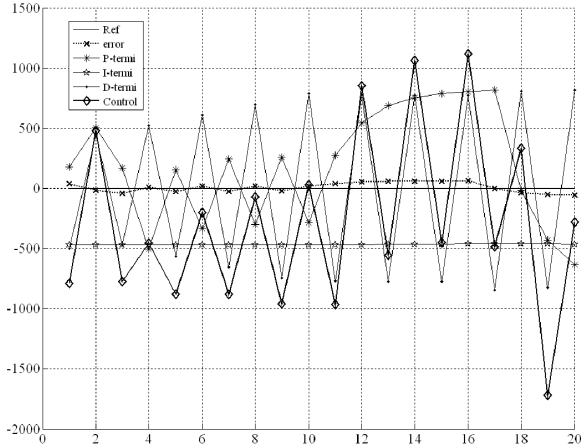
Figure 5: The testing of PID controller. Y-axle shows optimized PID- values in 20 different optimization runs